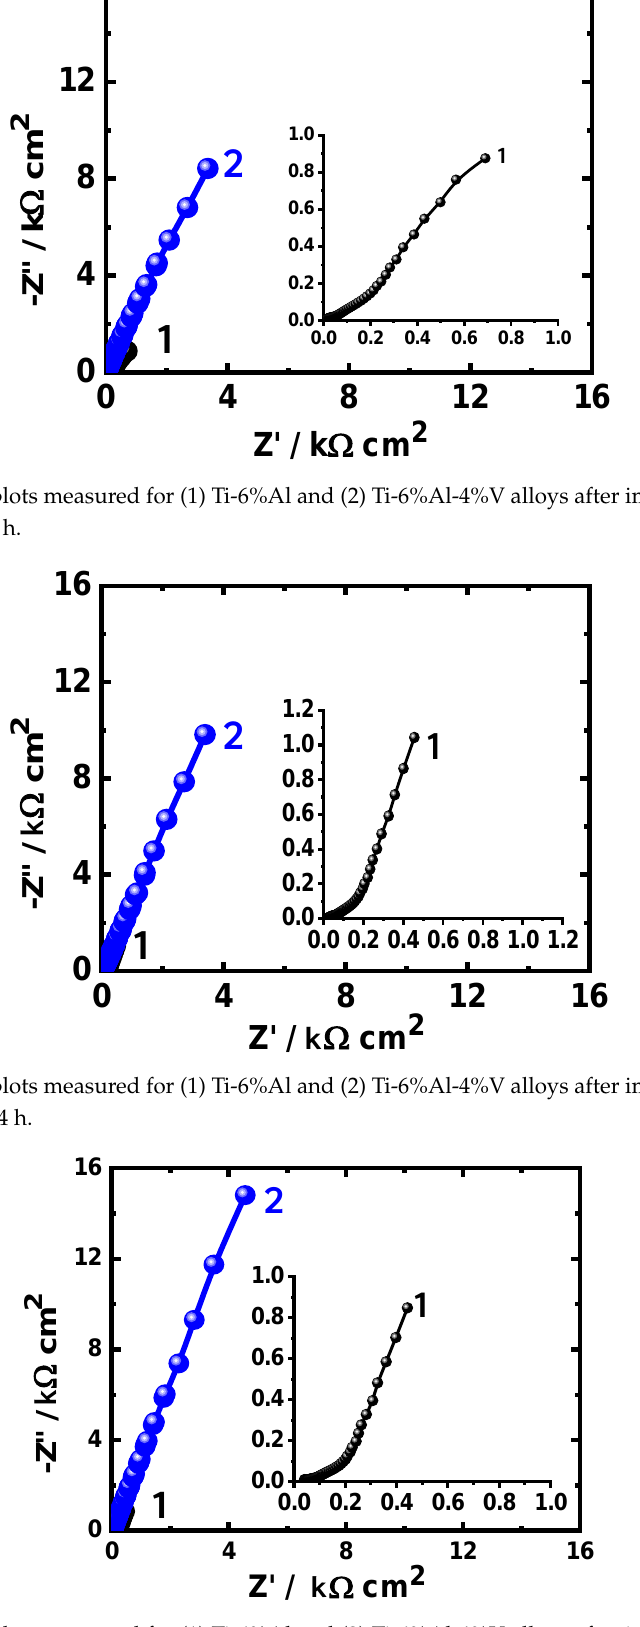
Figure 7. Nyquist plots measured for (1) Ti-6%Al and (2) Ti-6%Al-4%V alloys after immersion in 3.5% NaCl solution for 48 h.